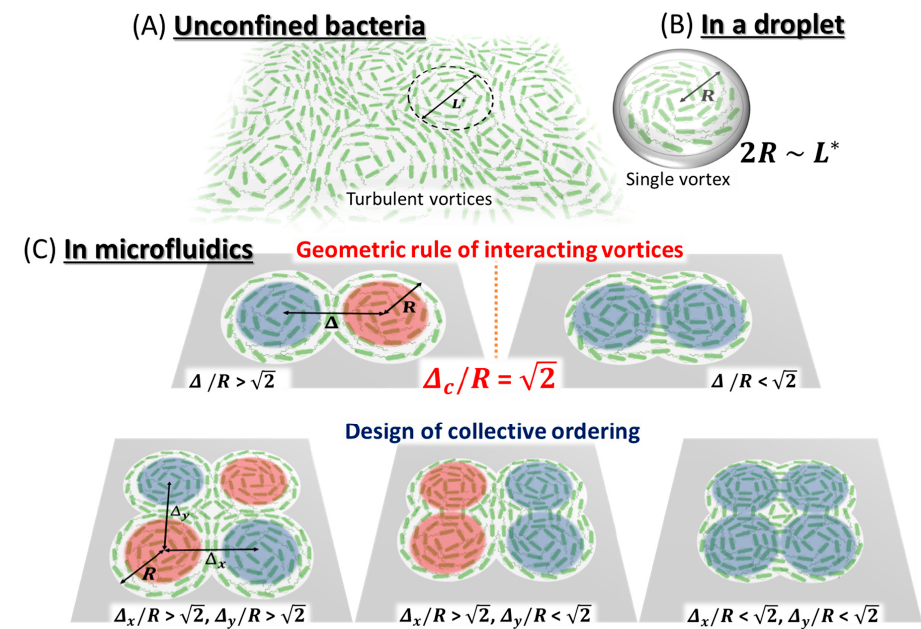
Figure 4. Schematic of the self-organization in bacterial suspensions from turbulent to rich ordered structures. ( a ) Meso-scale turbulence in a dense suspension of bacteria confined in the quasi-two-dimensional plane, which contains bacterial vortices having a characteristic size L *.